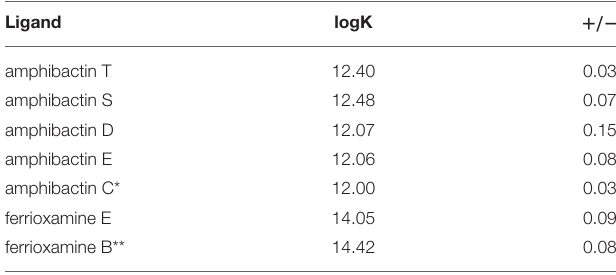
TABLE 4 | Conditional stability constants (logK) of isolated amphibactins from Vibrio cyclitrophicus 1F-53 , as well as model siderophores ferrioxamine E and B. Ligand logK + / − amphibactin T 12.40 0.03 amphibactin S 12.48 0.07 12.07 0.15 12.06 0.08 12.00